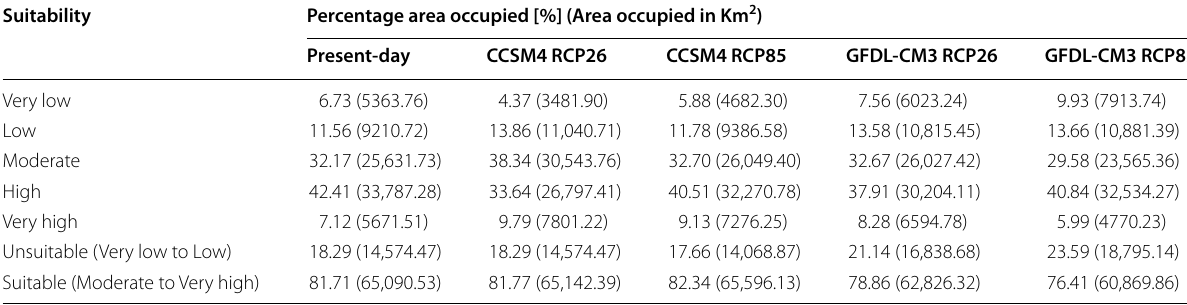
Table 2 Percentage climatic suitability of present-day and future conditions for An. gambiae